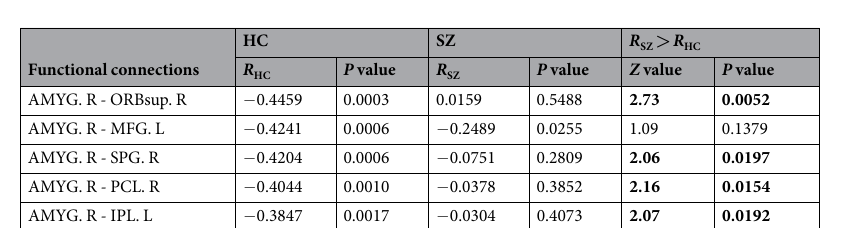
Table 3. Associations between age and SampEn of functional connections in healthy subjects and patients with schizophrenia. For the difference between R SZ and R HC , P values that could survive FDR correction are marked in bold. HC, healthy subjects; SZ, patients with schizophrenia; R HC , partial correlation coefficient of the healthy group; R SZ , partial correlation coefficient of the patient group; AMYG, amygdala; ORBsup, superior orbital frontal gyrus; MFG, middle frontal gyrus; SPG, superior parietal gyrus; PCL, paracentral lobule; IPL, inferior parietal gyrus; L, left; R,